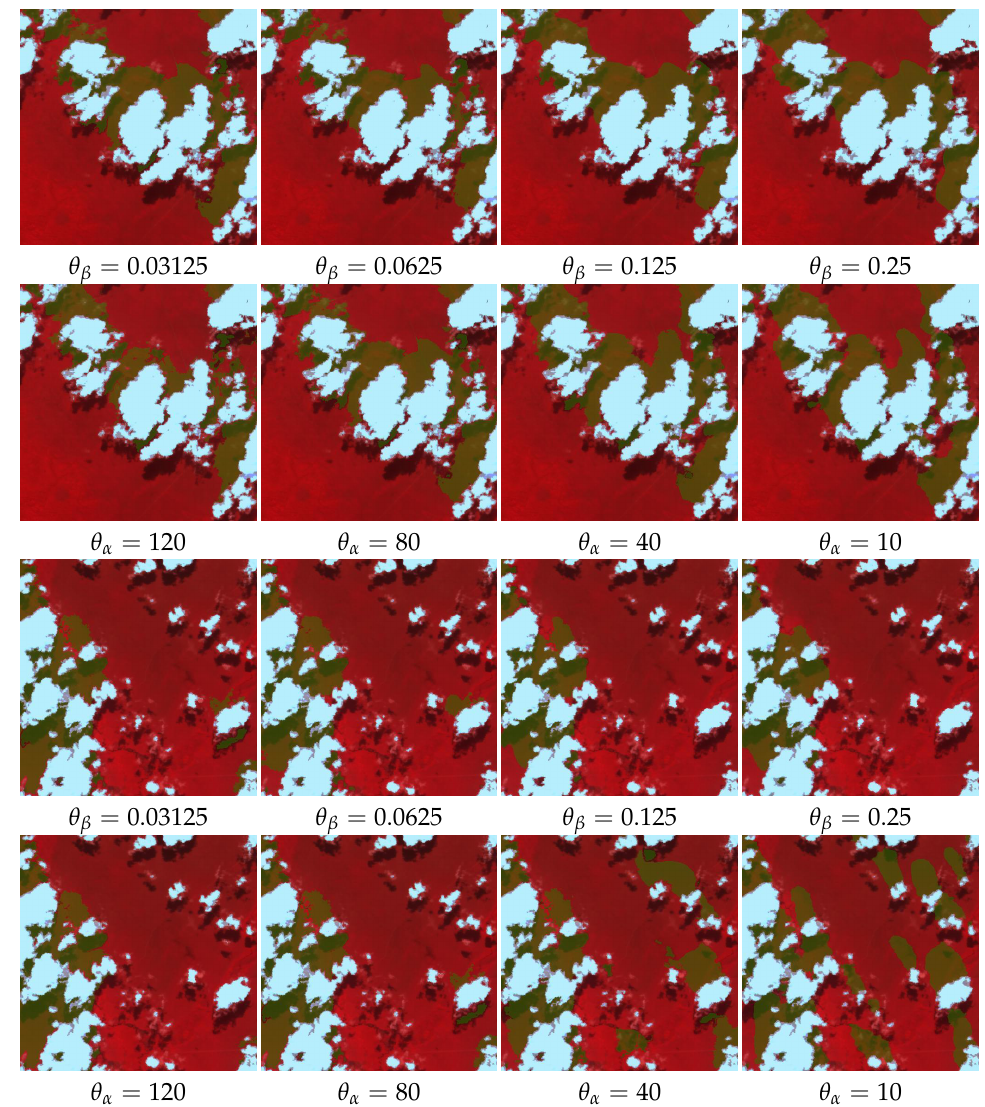
Figure 9. Illustrations of the effects of the critical hyperparameters